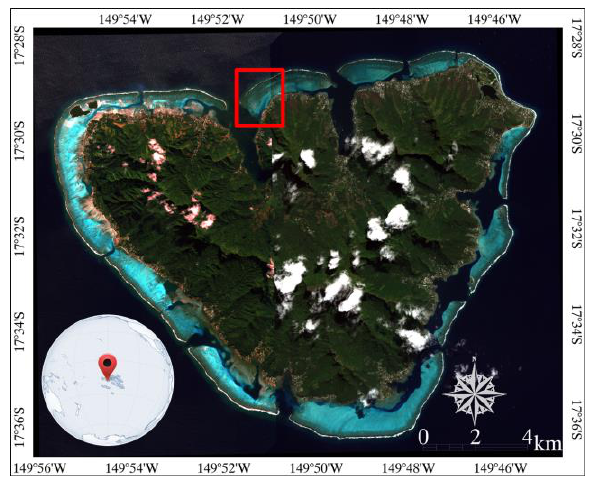
Figure 1. Natural-coloured WorldView-3 imagery of Moorea Island (French Polynesia)